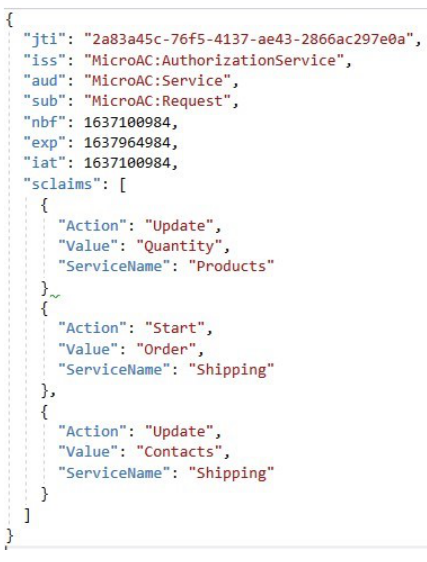
Figure 5. Structure of external JWT tokens.